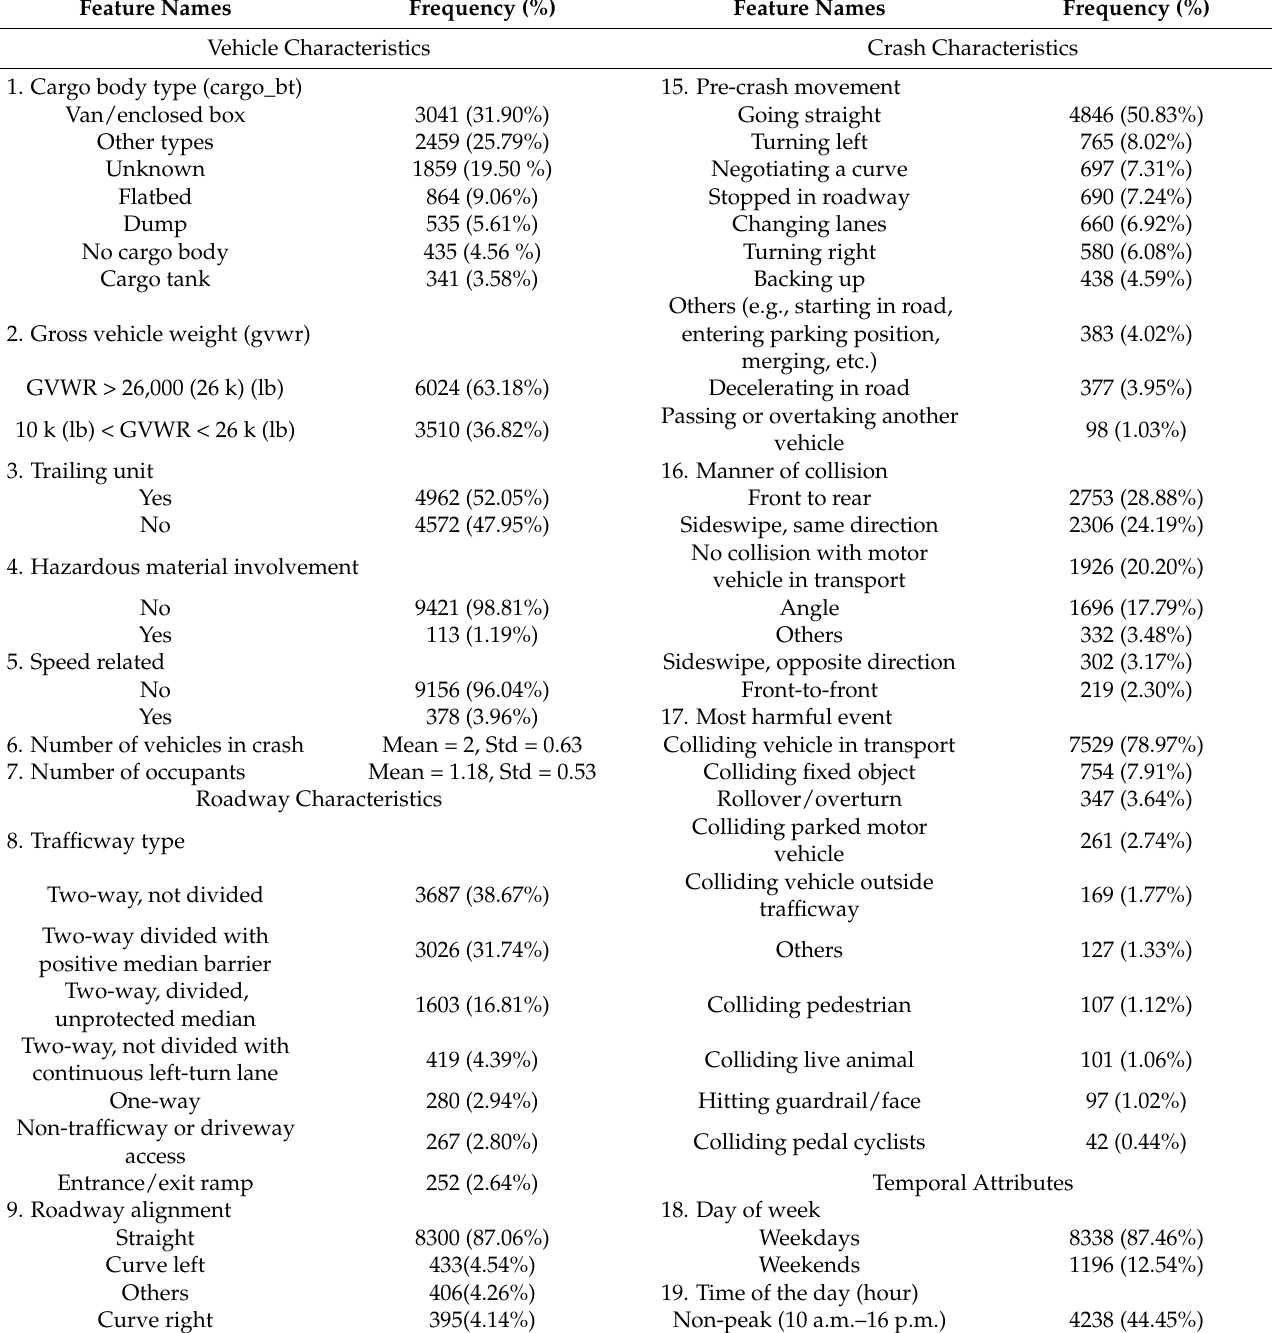
Table 3. Description of input